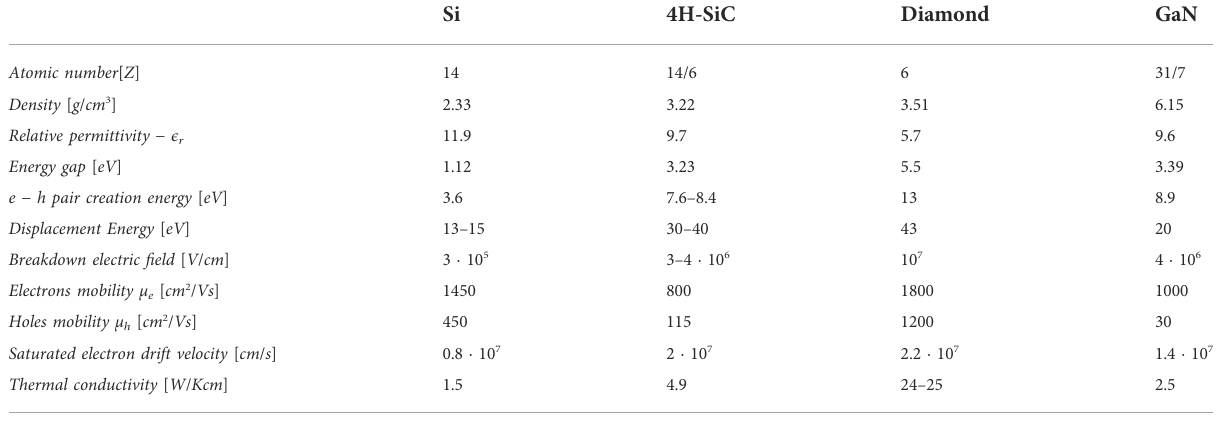
TABLE 1 4H-SiC properties at room temperature compared to Si, diamond and GaN.